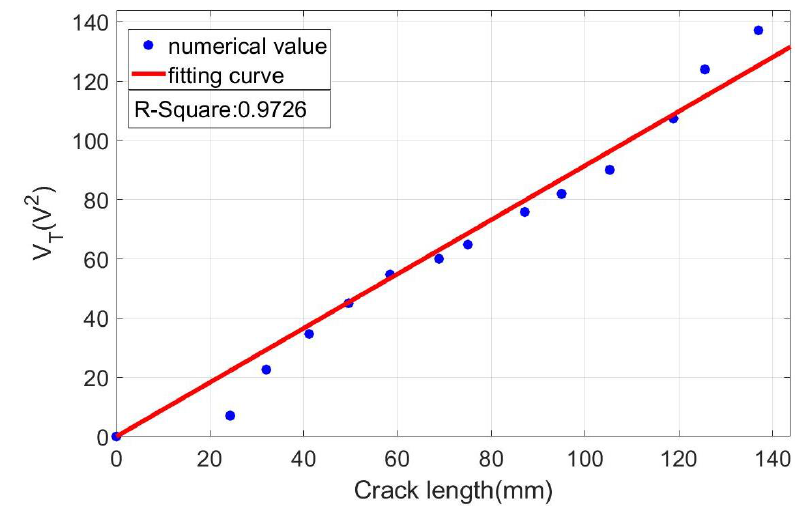
Figure 11. Relationship between the crack propagation length and voltage ( 𝑉 𝑇 ).